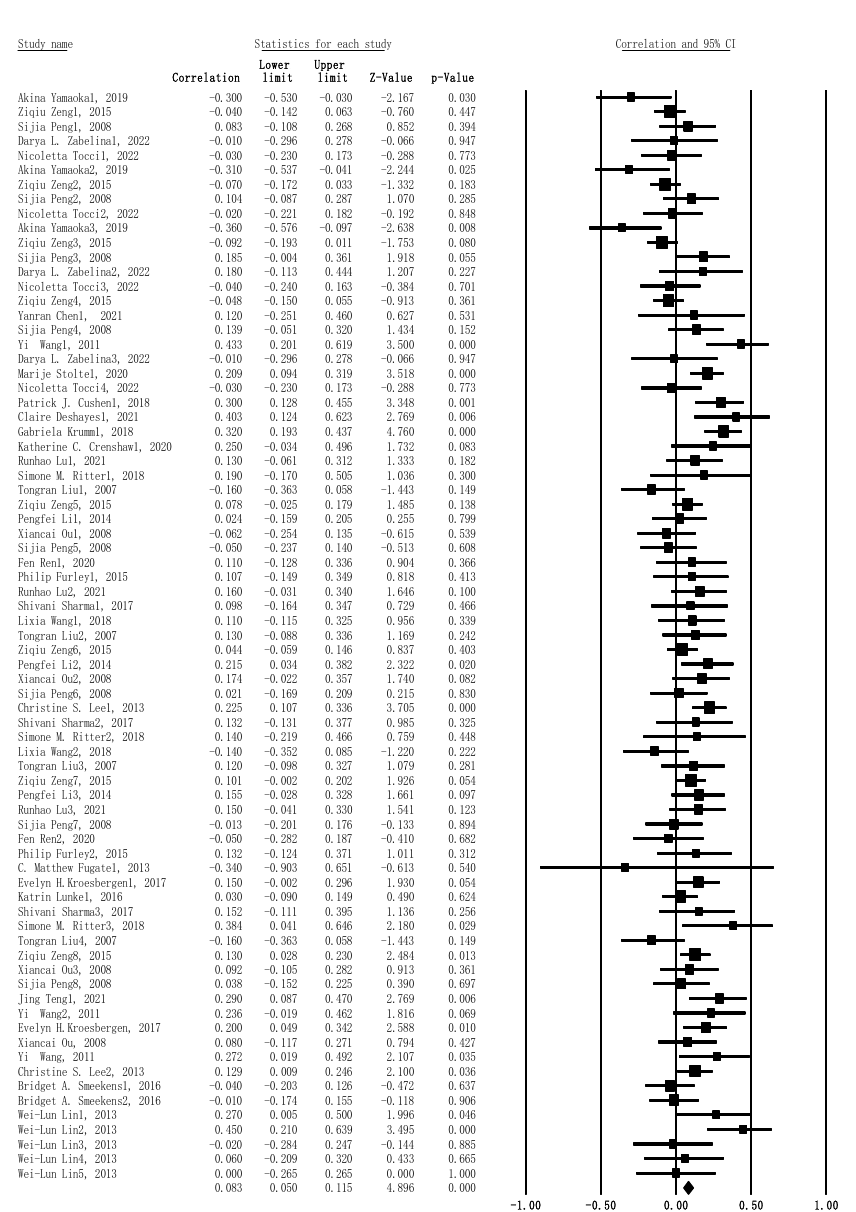
Figure 2. Forest plot for main meta-analysis concerning the association between WMC and creativity. Effect size was presented as z-value in this figure.